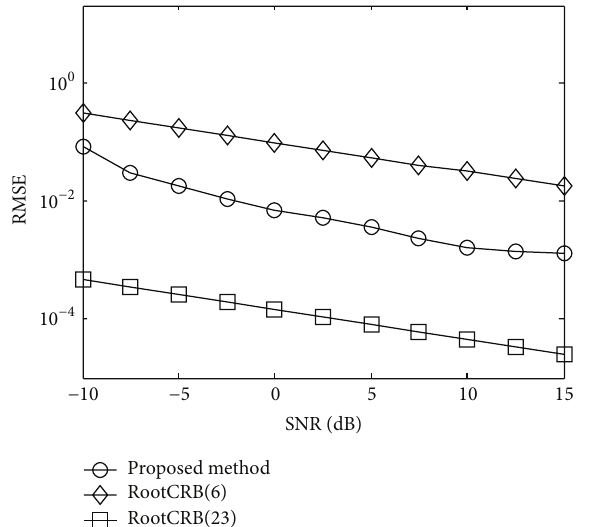
Figure 7: RMSE of angle versus SNR and snapshots, 𝑁 = 6 and 𝐾 = 13 .